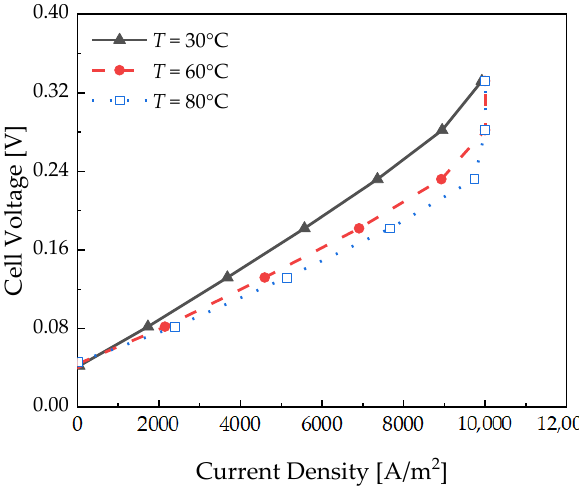
Figure 5. Polarization curve of the pseudo-2D electrochemical hydrogen compressor with respect to temperature.